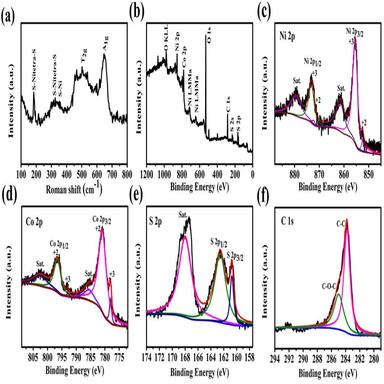
(a) Raman spectra of the scraped NiCo2S4 sample. (b) XPS survey spectrum and high-resolution scans for (c) Ni 2p, (d) Co 2p, (e) S 2p and (f) C 1s in the NiCo2S4/CC.